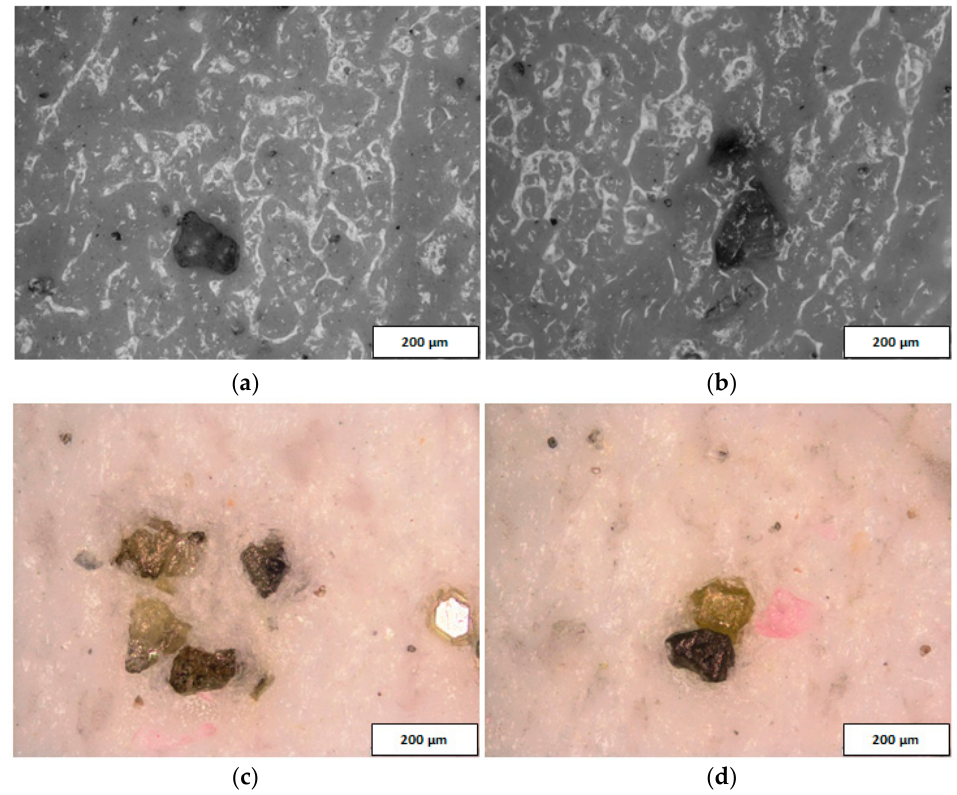
Figure 8. Selected sections of the tool’s active surface before ( a , b ) and after ( c , d ) cleaning from the abrasive suspension.